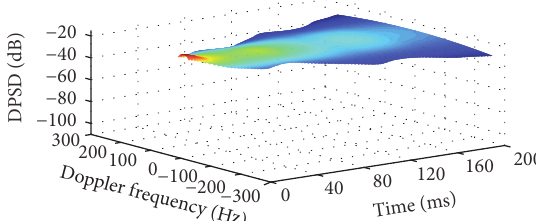
Figure 3: Time-variant Gaussian-shaped DPSD used to verify the performance of proposed simulator. This DPSD corresponds to the scenario of mobile receiver starting acceleration.